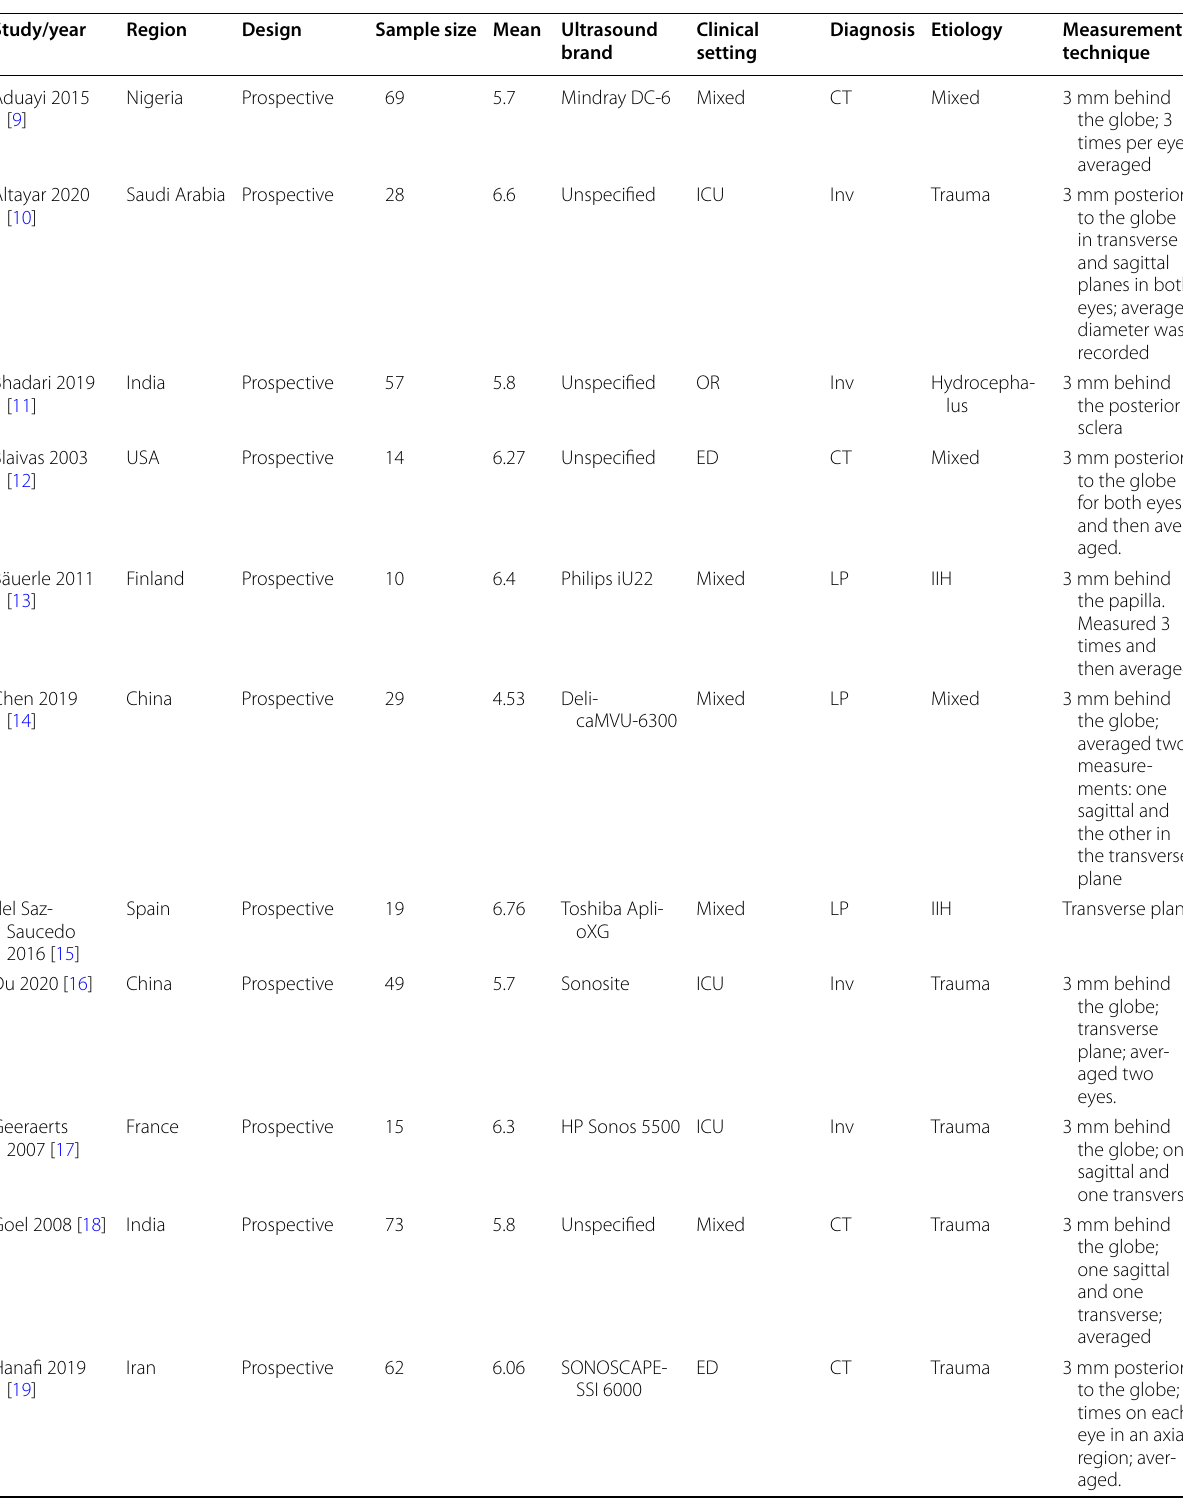
Table 1 Baseline characteristics of included